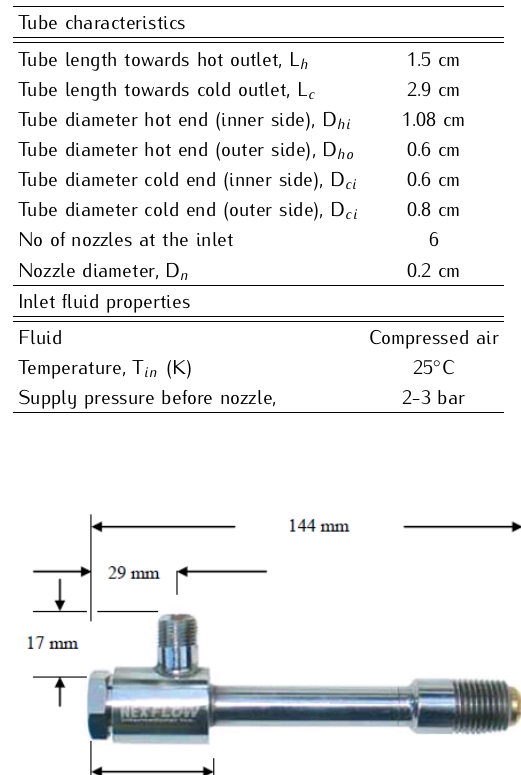
Table 1. Geometric measurement of vortex tube and fluid properties.